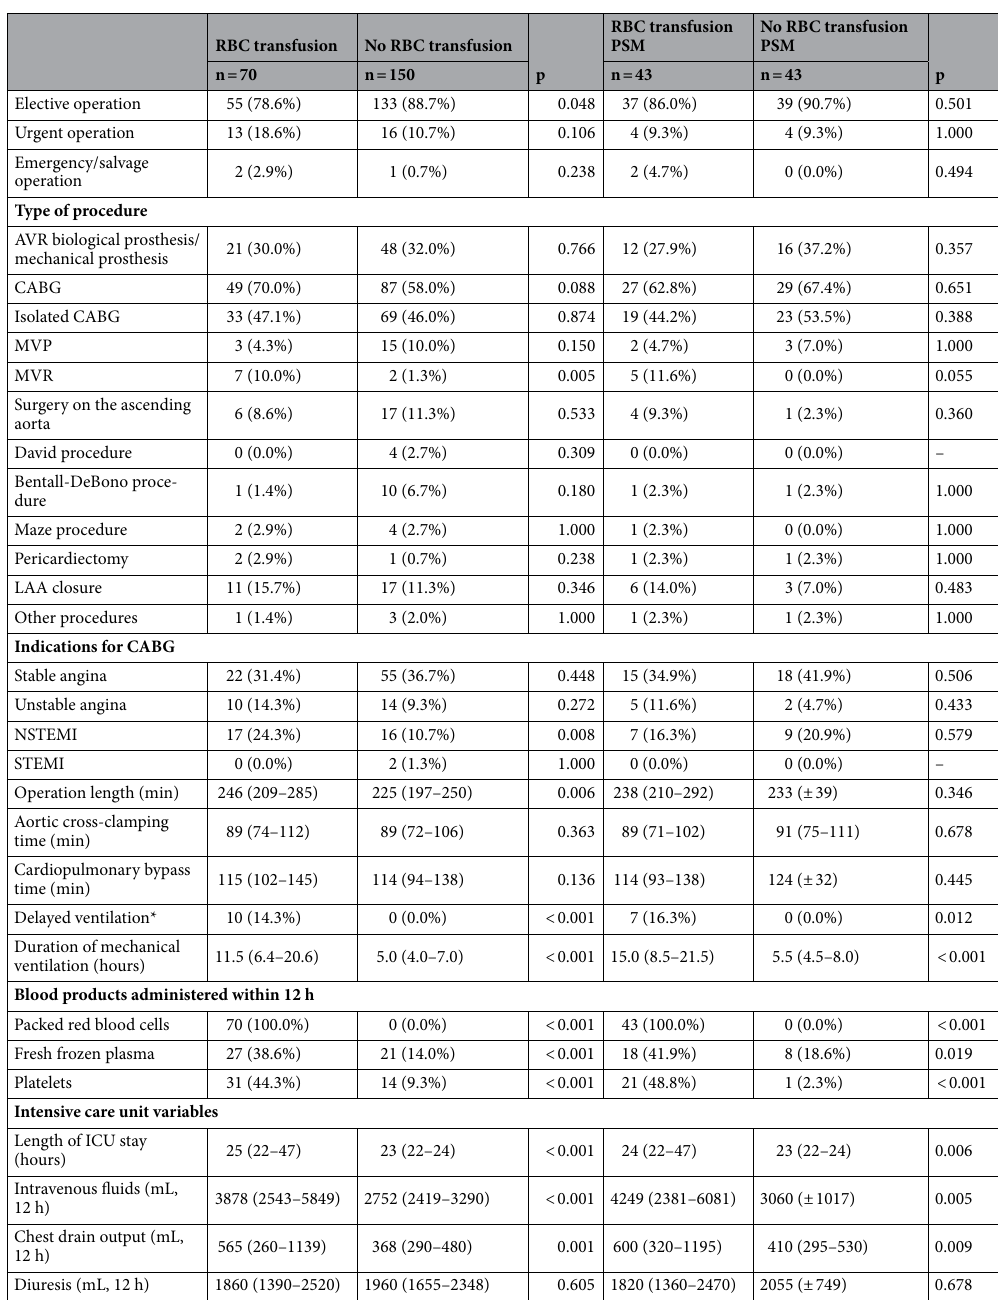
Table 2. Operative characteristics of the study cohorts. Continuous variables are reported as median and interquartile range or mean and standard deviation. Categorical variables are reported as counts and percentages. AVR aortic valve replacement, CABG coronary artery bypass grafting, ECMO extracorporeal membrane oxygenation, IABP intra-aortic balloon pump, ICU intensive care unit, LAA left atrial appendix, MVP mitral valve repair, MVR mitral valve replacement; NSTEMI non-ST-elevation myocardial infarction, RBC red blood cell, STEMI ST-elevation myocardial infarction. *Delayed ventilation > 24